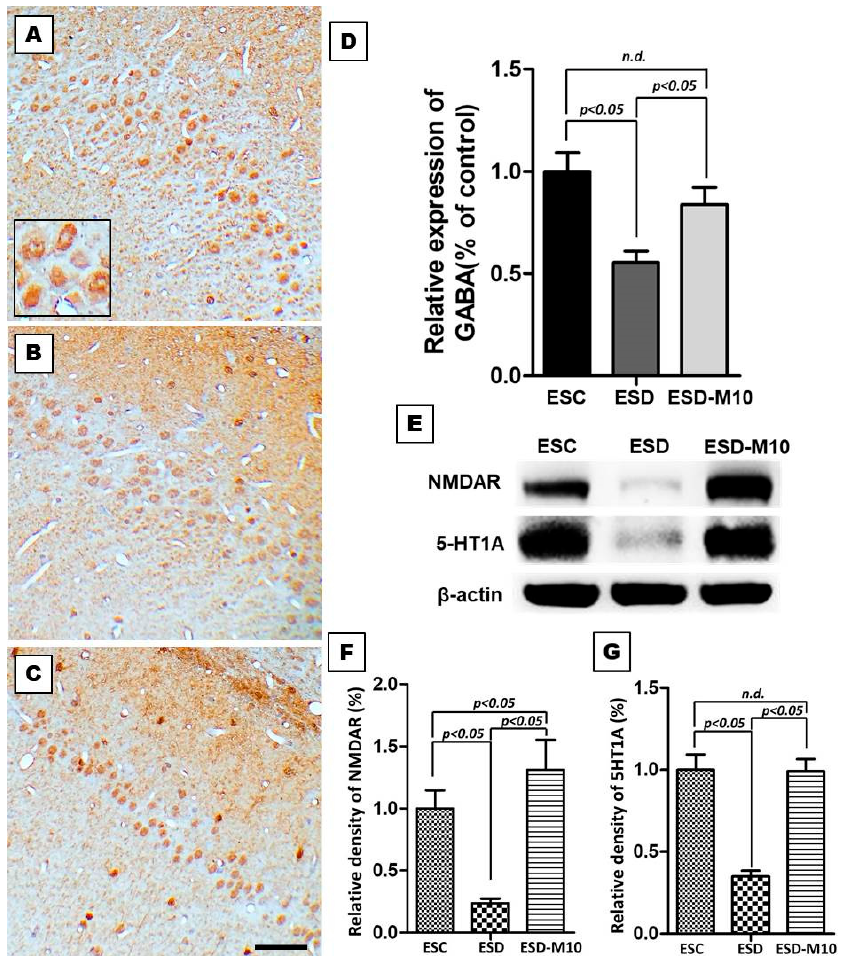
Figure 4. Photomicrographs ( A – C ) and histogram ( D ) show the extent of GABA expressions in the CA1 region of the hippocampus ( A – C ). Note that ESD rats demonstrated decreased GABAergic interneuron density in the hippocampus. In ESD-M10 group, the hippocampal GABA immune-expression significantly increased ( C ). Immunoblots ( E ) and histograms ( F , G ) show the protein expression level of 5-HT1 A and NMDAR in the hippocampus of ESC, ESD, and ESD-M10 groups. These activities were highest among ESC rats. Following ESD, protein expressions involved in neurotransmitter and receptor activities were significantly reduced ( p < 0.05). However, in the animals treated with melatonin during the ESD period, effective expressions of 5-HT1 A and NMDAR significantly increased when compared with the ESD group ( p < 0.05). Scale bars: 200 μ m.